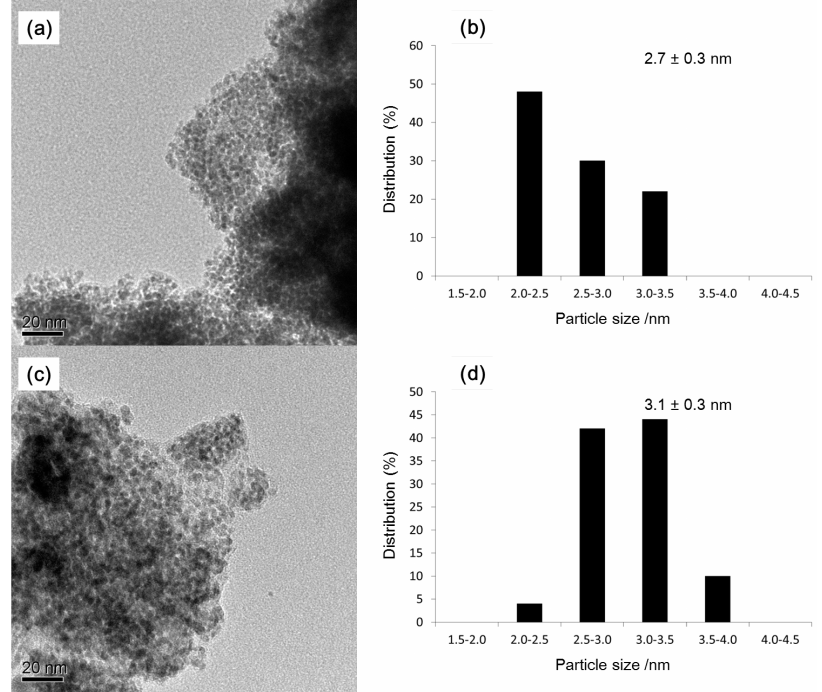
Figure 4. ( a ) TEM micrograph of PS-PdNPs (scale bar = 20 nm); ( b ) size distribution of PS-PdNPs; ( c ) TEM micrograph of recovered catalyst after fifth run (scale bar = 20 nm); ( d ) size distribution of recovered catalyst after fifth